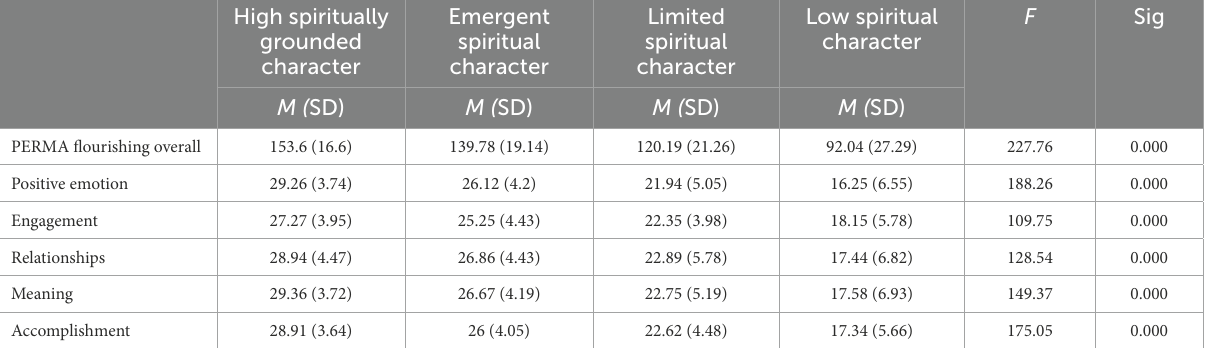
TABLE 5 Means and standard deviations of PERMA Profiler scores by profile membership; F statistic of one-way ANOVA